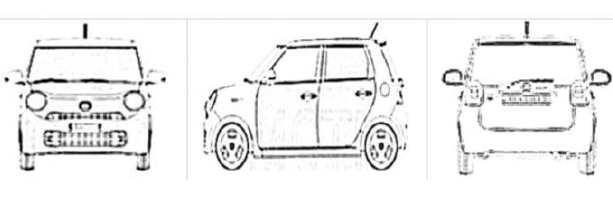
Fig. 7. Blueprints of Honda N-One 2013 (a) Front view (b) Side view (c) Back view